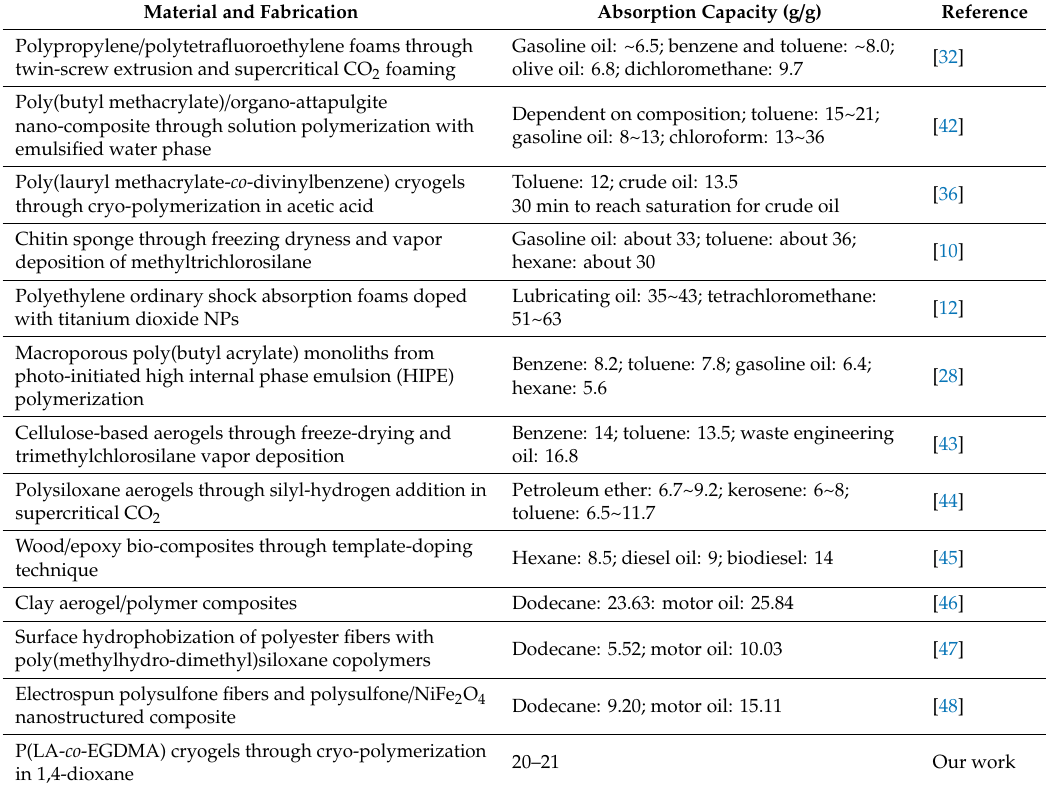
Table 2. Comparison of our fabricated material absorption capacity with other reported